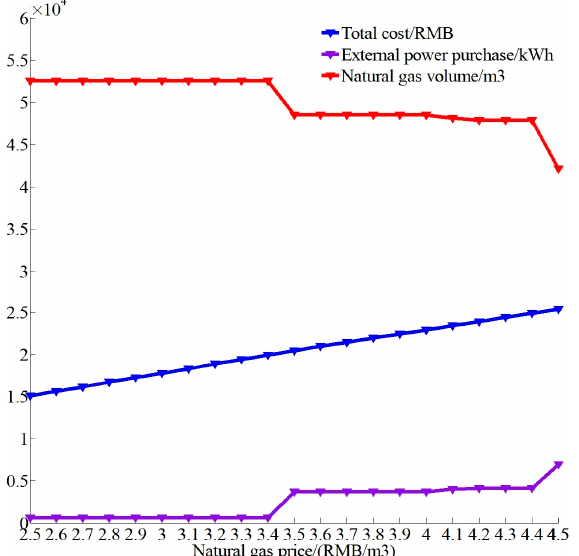
Figure 9. Total cost, external power purchase, and natural gas volume (natural gas price changes). When the unit price of natural gas changes from 3.5 RMB/m 3 to 4.4 RMB/m 3 , the The results for when the electricity tariff changes from 0.5 times the original price to 1.5 times are shown in Figure 10.